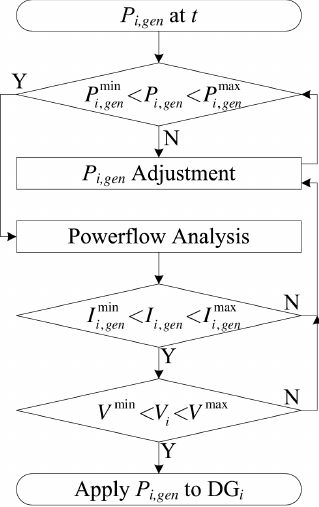
Figure 3. Power control procedure at each time step.